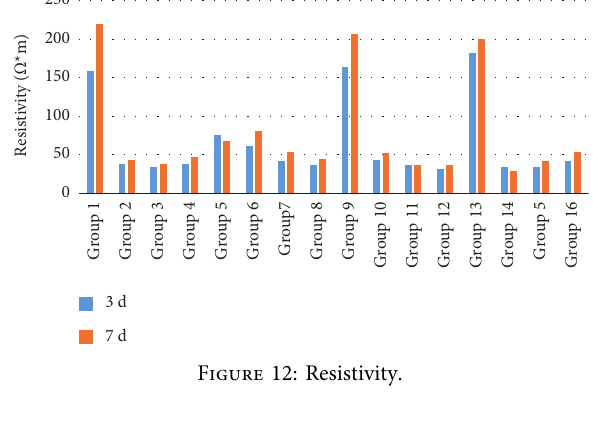
Figure 12: Resistivity.